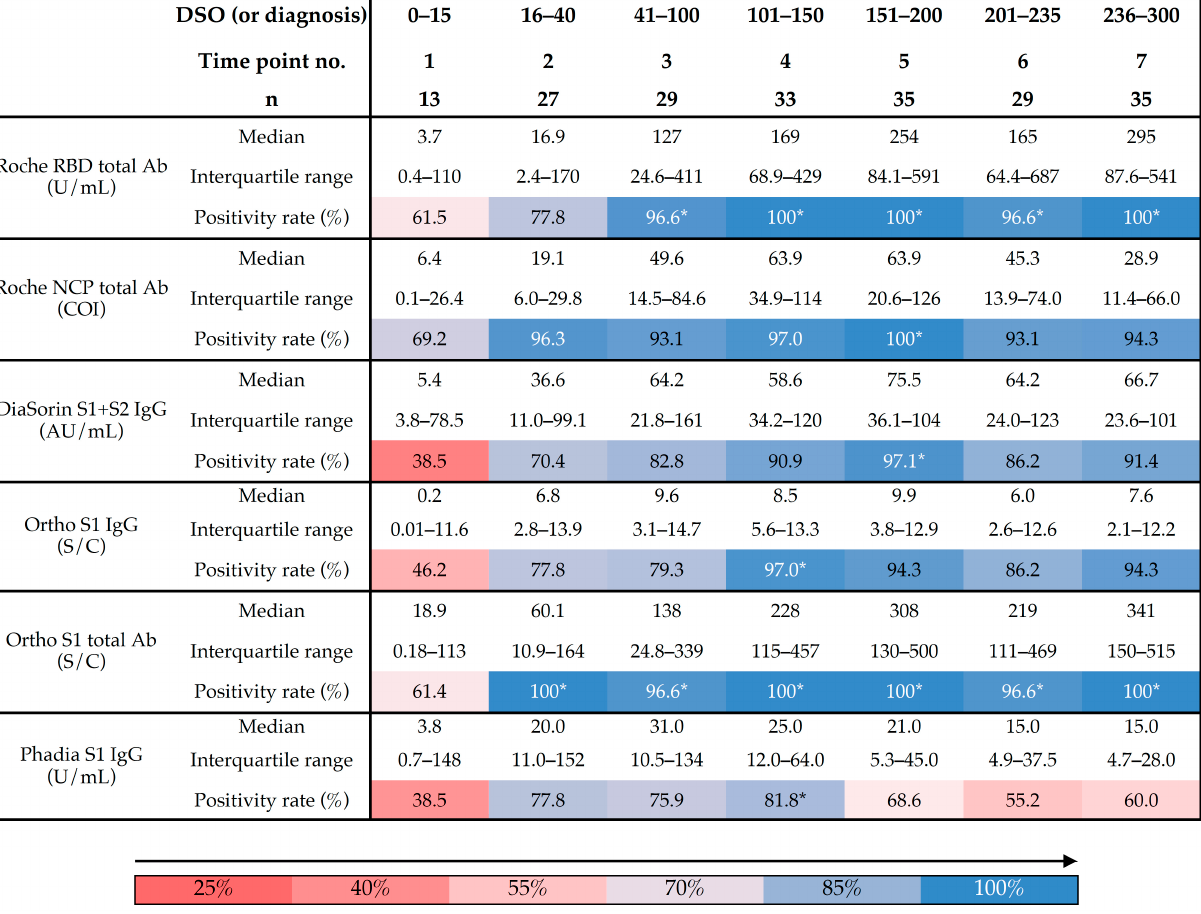
Table 2. Positivity rates according to different time points using six different assays. * represents maximal positivity rates observed. DSO = days since symptom onset.